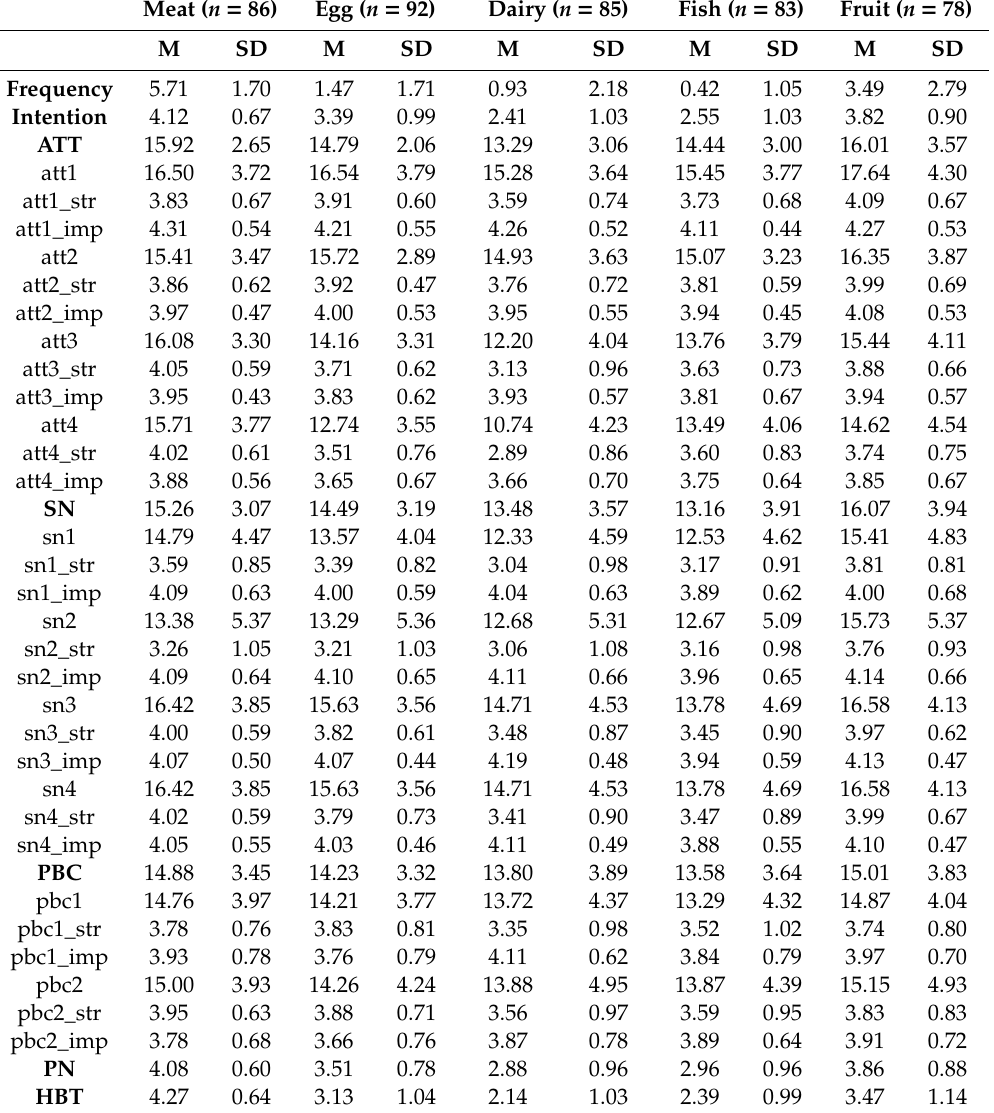
Table A1. Descriptive statistics (means, standard deviations) of the TPB construct items for predicting consumption frequency of meat, eggs, dairy, fish, and